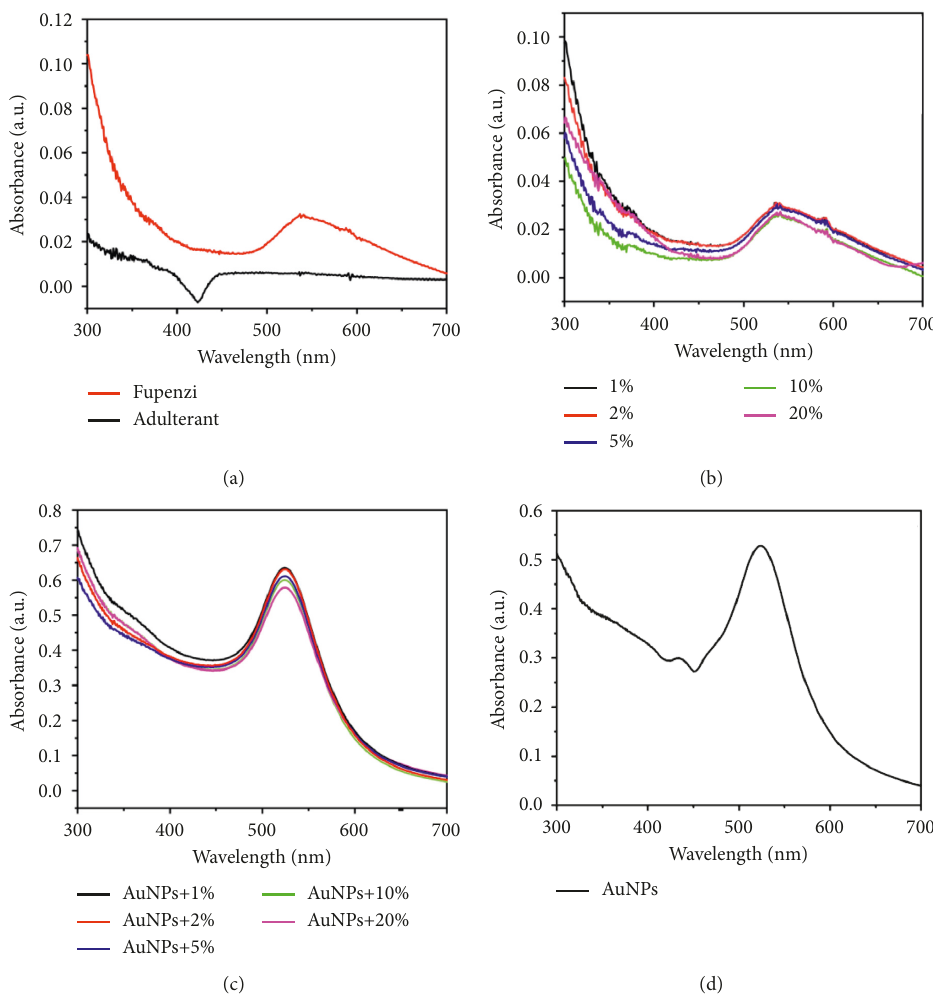
Figure 3: UV-vis spectrum of Fupenzi, AuNPs, and adulterants. (a) UV-vis spectrum of raspberry and adulterants; (b) UV-vis spectrum of mixtures with different concentrations; (c) UV-vis spectrum of AuNPs combined with mixtures of different concentrations; (d) AuNP UV- vis spectrum in ultrapure